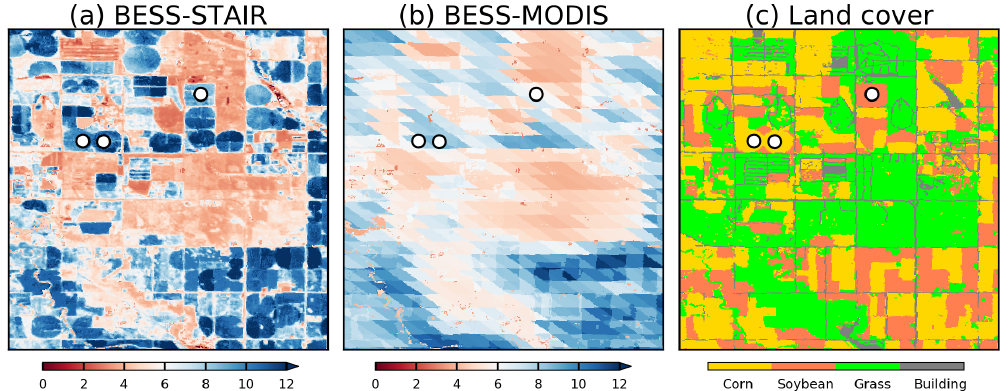
Figure 8. Daily ET (MJm − 2 d − 1 ) derived from (a) BESS-STAIR and (b) BESS-MODIS at Mead (41.1–41.2 ◦ N, 96.4–96.5 ◦ W) on 1 Au- gust 2012. Circles indicate flux towers in this